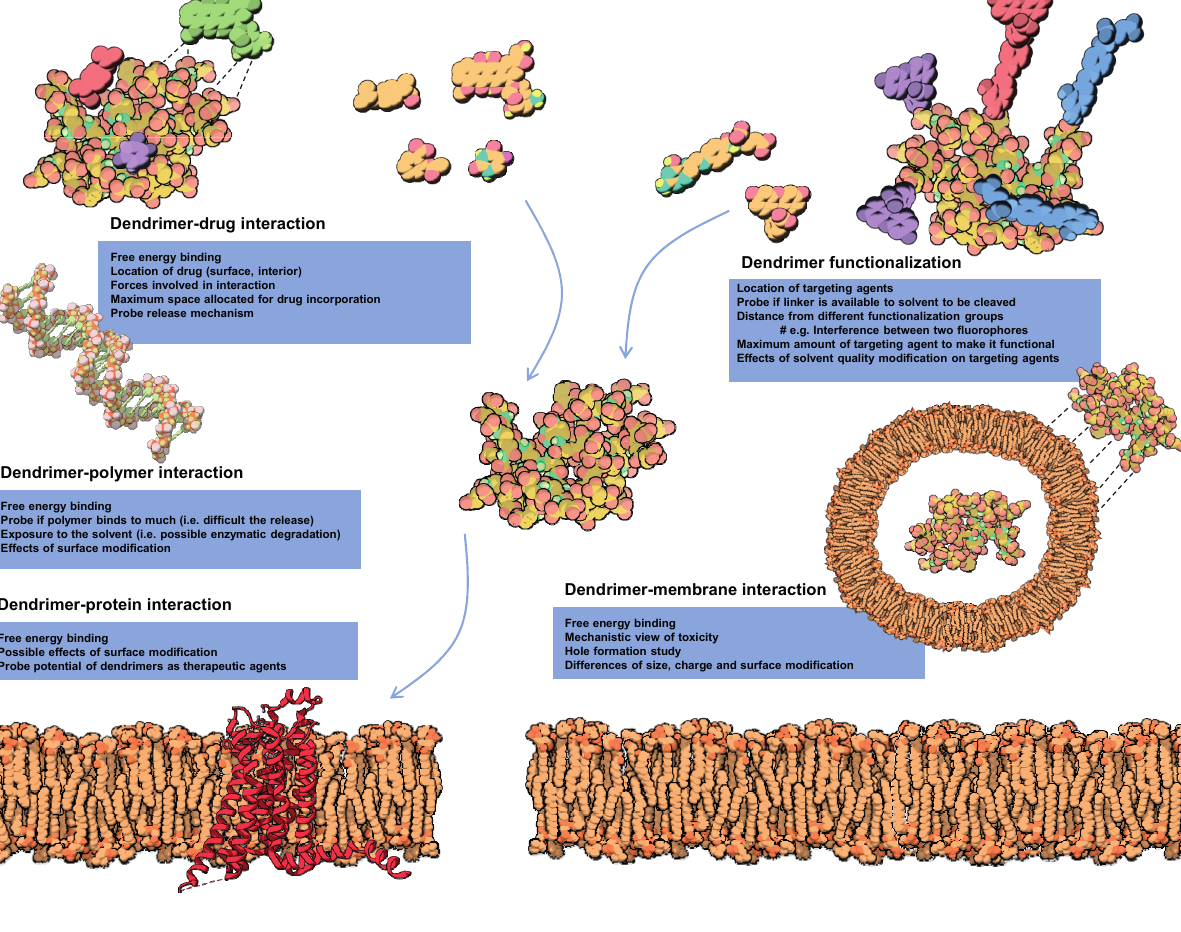
Dendrimer-protein